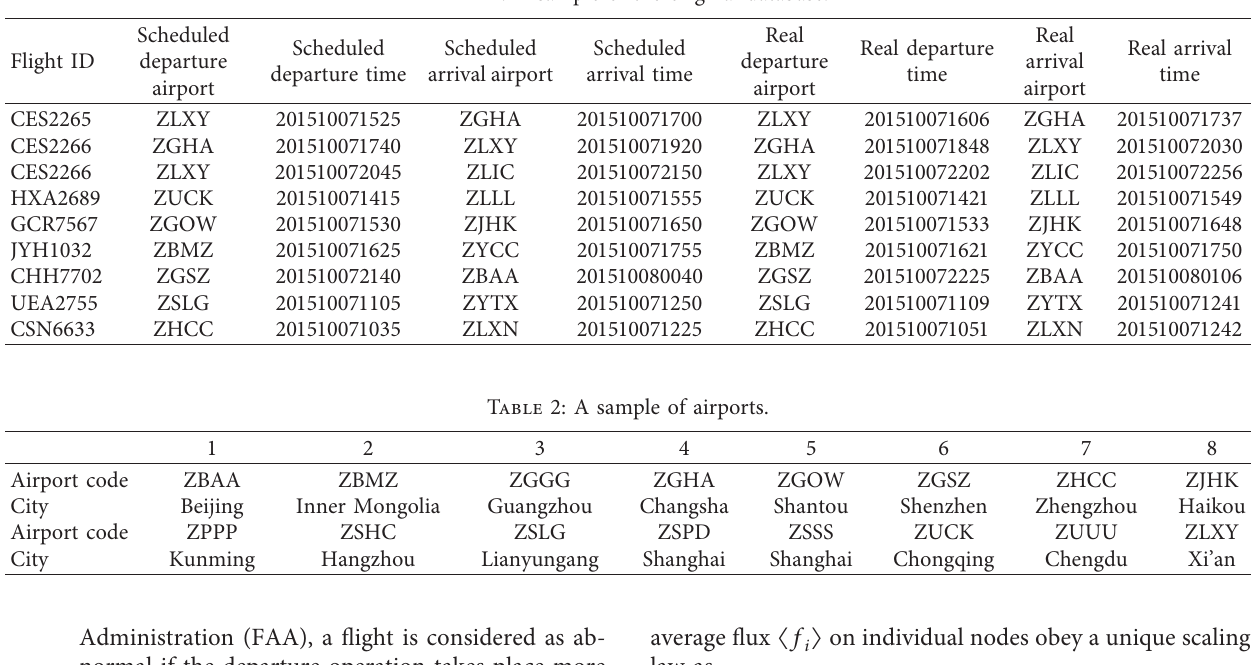
Table 1: A sample of the original database.